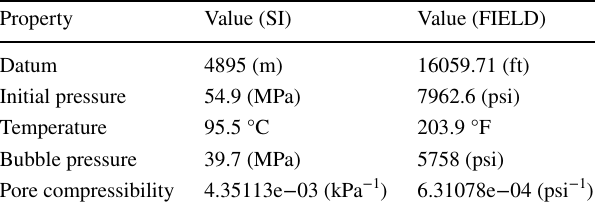
Table 1 Reservoir data Property